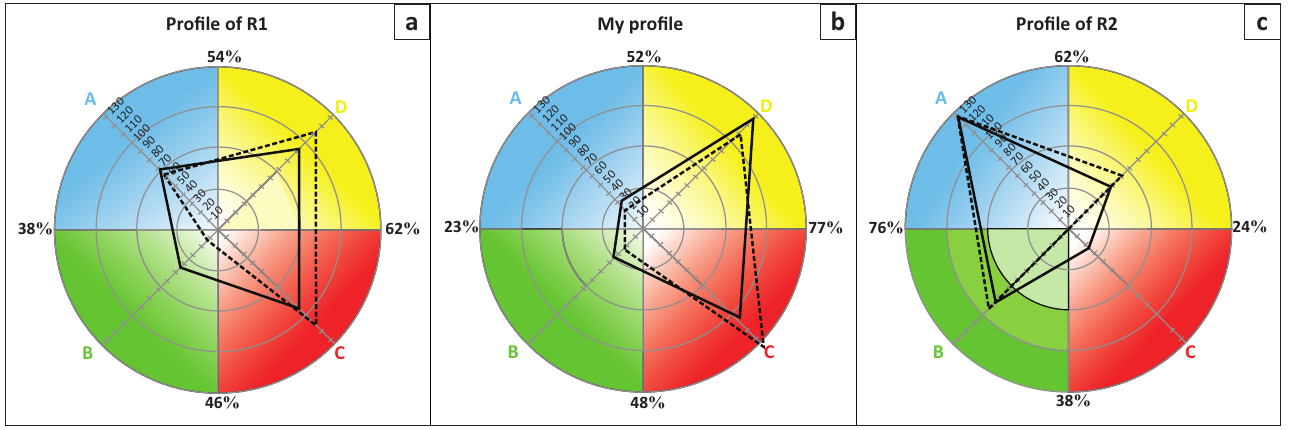
FIGURE 1: Visual representation of my thinking profile (b) and that of two students (a and c).